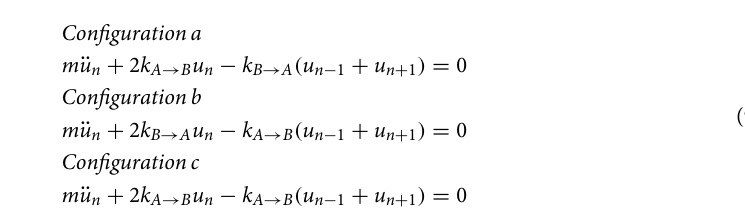
Figure 5. Topological Mechanics of Diatomic Lattices with Nonreciprocal Elastic Springs. ( a – c ) Three configurations of a diatomic lattice model. Nonreciprocal springs made of the developed metamaterial are considered such that the stiffness is different when the spring is stretched/compressed from two opposite ends ( k A B > k B A ). The free body diagrams of the spring forces and the inertia forces are represented when ( a ) → → atoms vibrate to the right, ( b ) when atoms vibrate to the left, and ( c ) when each atom vibrates opposite to its q two neighbor-atoms. ( d ) The band structure ω of the diatomic lattice for different values of the nonreciprocal 0.5 (left), ǫ 0 (middle), and ǫ 0.5 (right). ( e ) The acoustic and optical frequencies elasticity parameter, ǫ (cid:30) (cid:31) = = = − 0, π/ 2 and π , versus the nonreciprocal elasticity parameter ǫ . The insets represent at different wavenumbers, q = q the Floquet–Bloch eigenmodes. ( f ) Contour plots of the acoustic and optic eigenmodes (cid:31) in the complex plan for different values of the nonreciprocal elasticity parameter ǫ (cid:30) (cid:31)